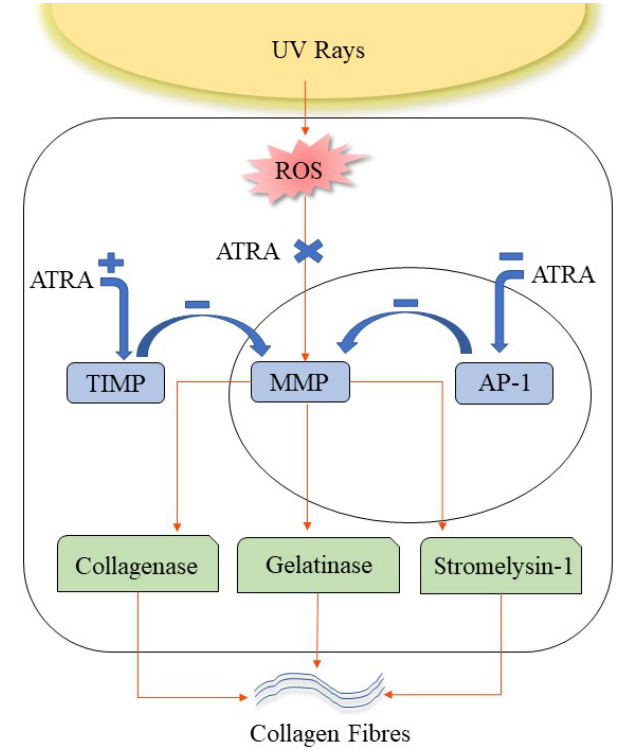
Figure 4. Action of ATRA inhibiting MMP through TIMP and AP-1 in the collagen degradation pathway of photoaged skin (MMP: matrix metalloproteinase; TIMP: tissue inhibitor of matrix metalloproteinase; AP-1: activator protein 1).